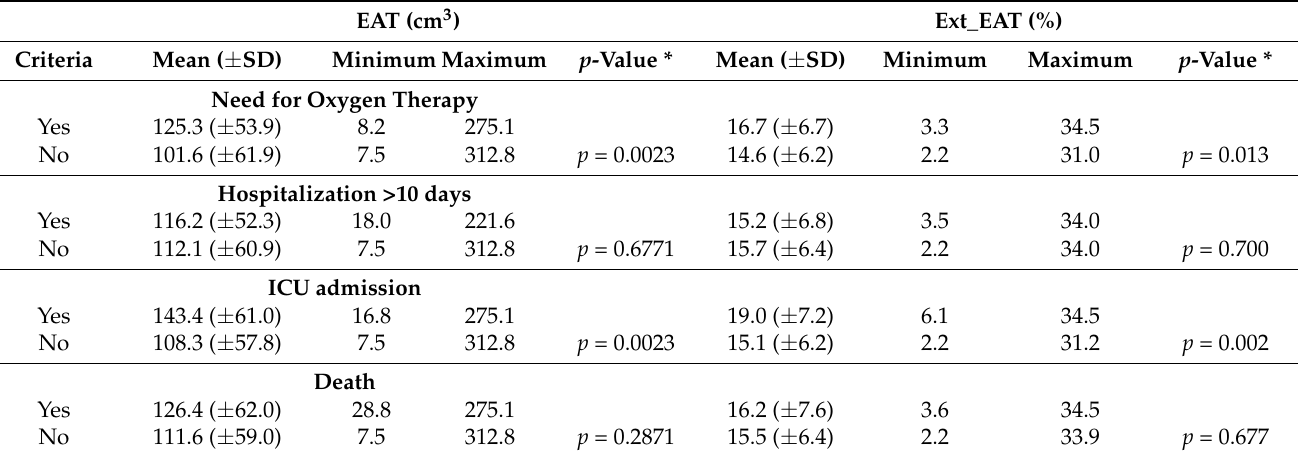
Table A2. Associations with combined clinical outcome (death, ICU transfer, need for oxygen therapy, >10 days hospitalization)—Multivariable logistic regressions adjusted on age, gender, and number of comorbidities (n = 238). DL: Deep-Learning model; EAT: epicardial adipose tissue volume (cm 3